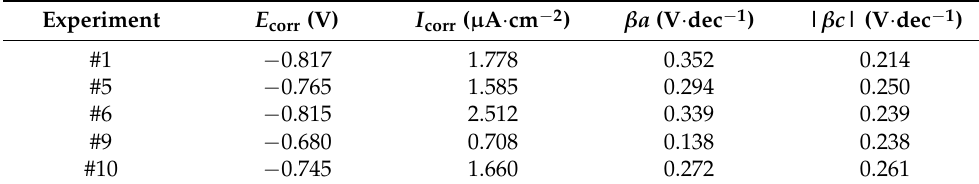
Table 6. Fitted data of polarization curves corresponding to Figure